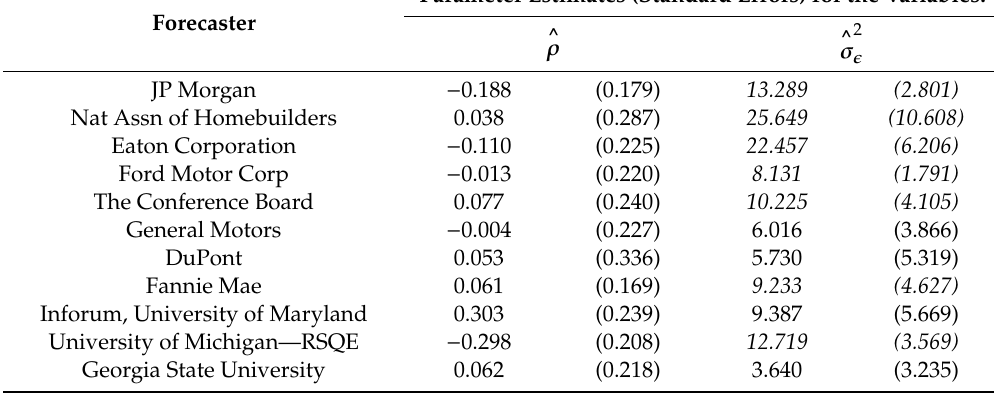
Table 3. Estimation results for (1) for forecasting unemployment, USA, 1996–2018. Italics means significant at the 10%